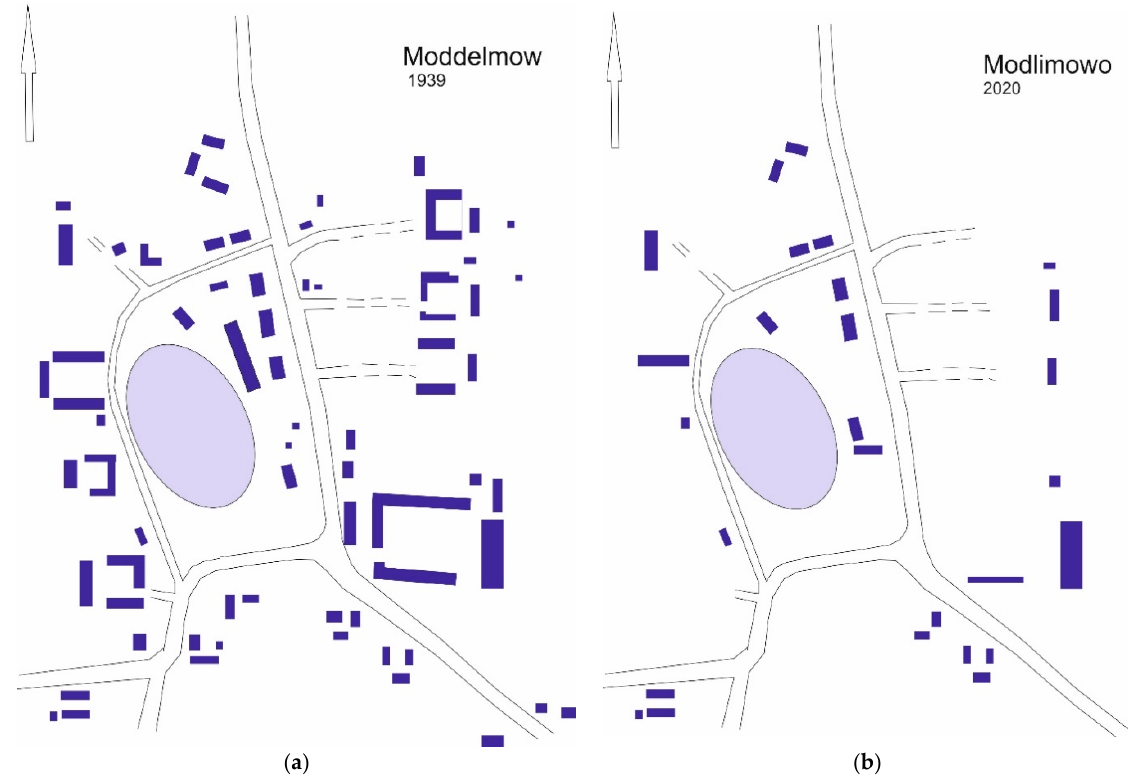
Figure 5. ( a ) Map of the village of Muddelmow (Modlimowo) state of preservation from 1939; ( b ) map of the village of Modlimowo 2020. Created by author.